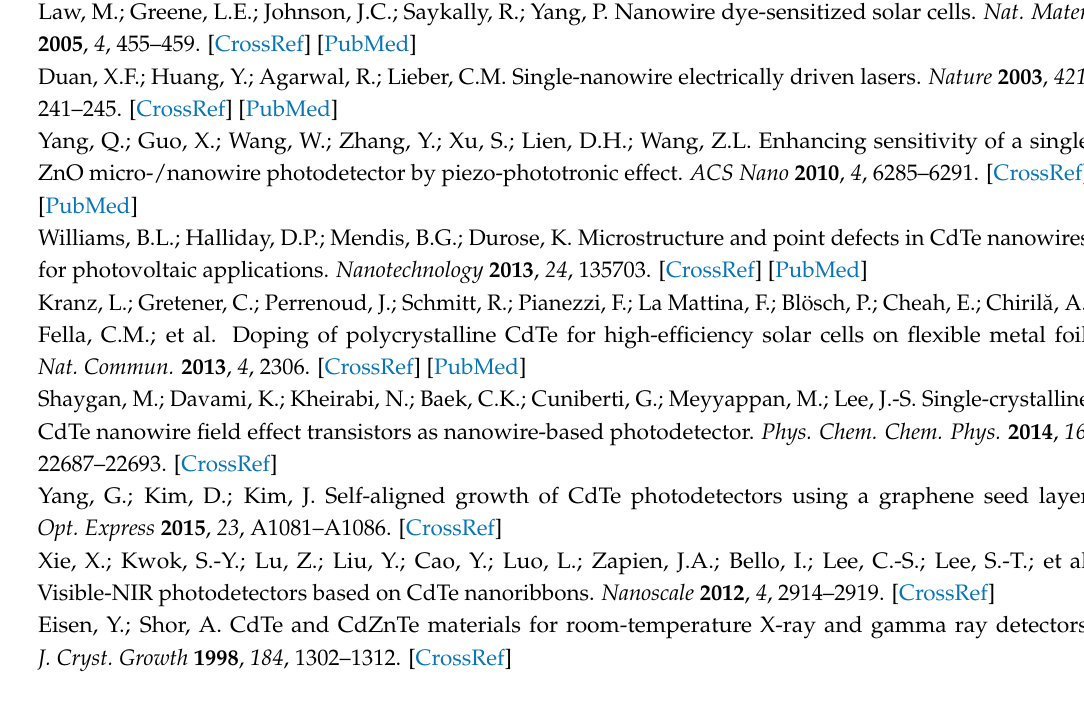
Figure S1. SEM images of CdTe grown with and without Bi films under different substrate temperature (a) 250 ◦ C; (b) 350 ◦ C and (c) 450 ◦ C, Figure S2. Photograph images of CdTe grown with and without Bi films on (a) Al2O3 (b) Si and (c) ITO substrate, Figure S3. SEM image of CdTe microdots arrays grown on Bi coated ITO substrate, Table S1: Hall effect measurements for CdTe microdots, Figure S4. Current vs. time characteristics of CdTe thin films under with press and without press conditions, Figure S5. Current values of the device under normal and under stress (pressing)